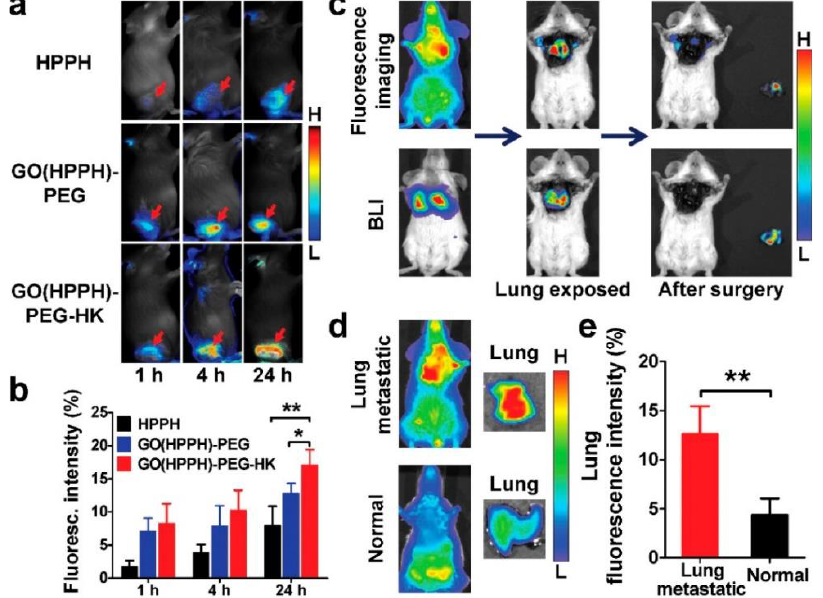
Figure 6. ( a ) Optical images of 4T1 tumor-bearing BALB/c mice, ( b ) quantitative analysis uptake by 4T1 tumors after injection of HPPH, GO(HPPH)-PEG, or GO(HPPH)-PEG-HK, ( c ) In vivo optical imaging and BLI of 4T1-fLuc tumor-bearing BALB/c mice after injection of GO(HPPH)-PEG-HK. ( d , e ) Optical images and quantitative analysis of lung uptake of GO(HPPH)-PEG-HK by 4T1-fLuc tumor-bearing and normal BALB/c mice at 24 h post-injection. Reprinted with permission from reference [83]. Copyright 2017 American Chemical Society. * p < 0.05, ** p <